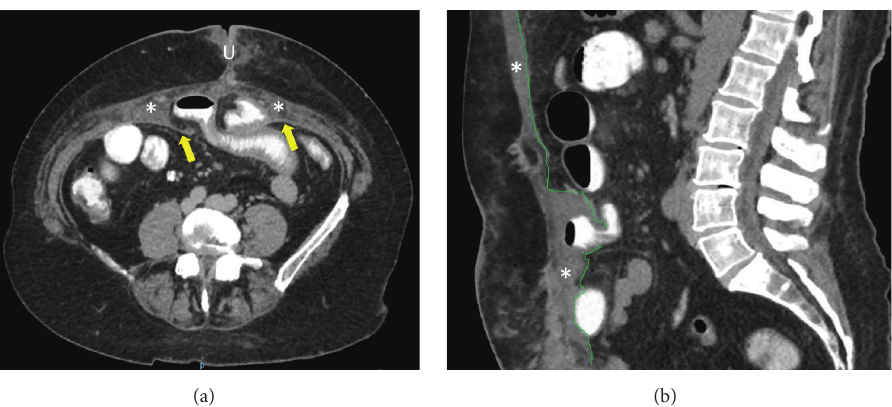
Figure 1: CT scan with intravenous and oral contrast. (a) Axial view. Defect in the posterior rectus sheath (arrows) with small bowel loops between parietal layers. ( ∗ ) Rectus abdominis muscle. U: umbilicus. (b) Sagittal view shows distension of proximal bowel loops consistent with a small bowel obstruction.